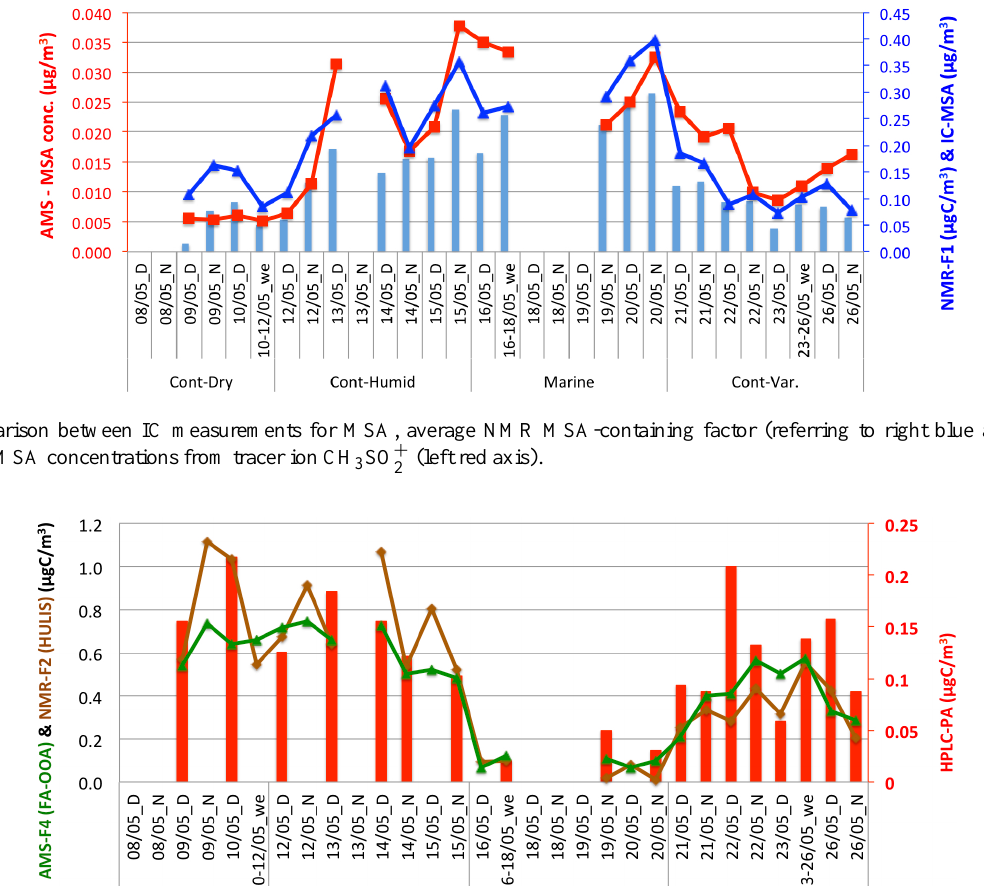
Fig. 7. Comparison between HPLC PA fraction, AMS-F4 and NMR-F2: the figure reports time series of AMS and NMR factors (left black axis) and of HPLC PA fraction (right red